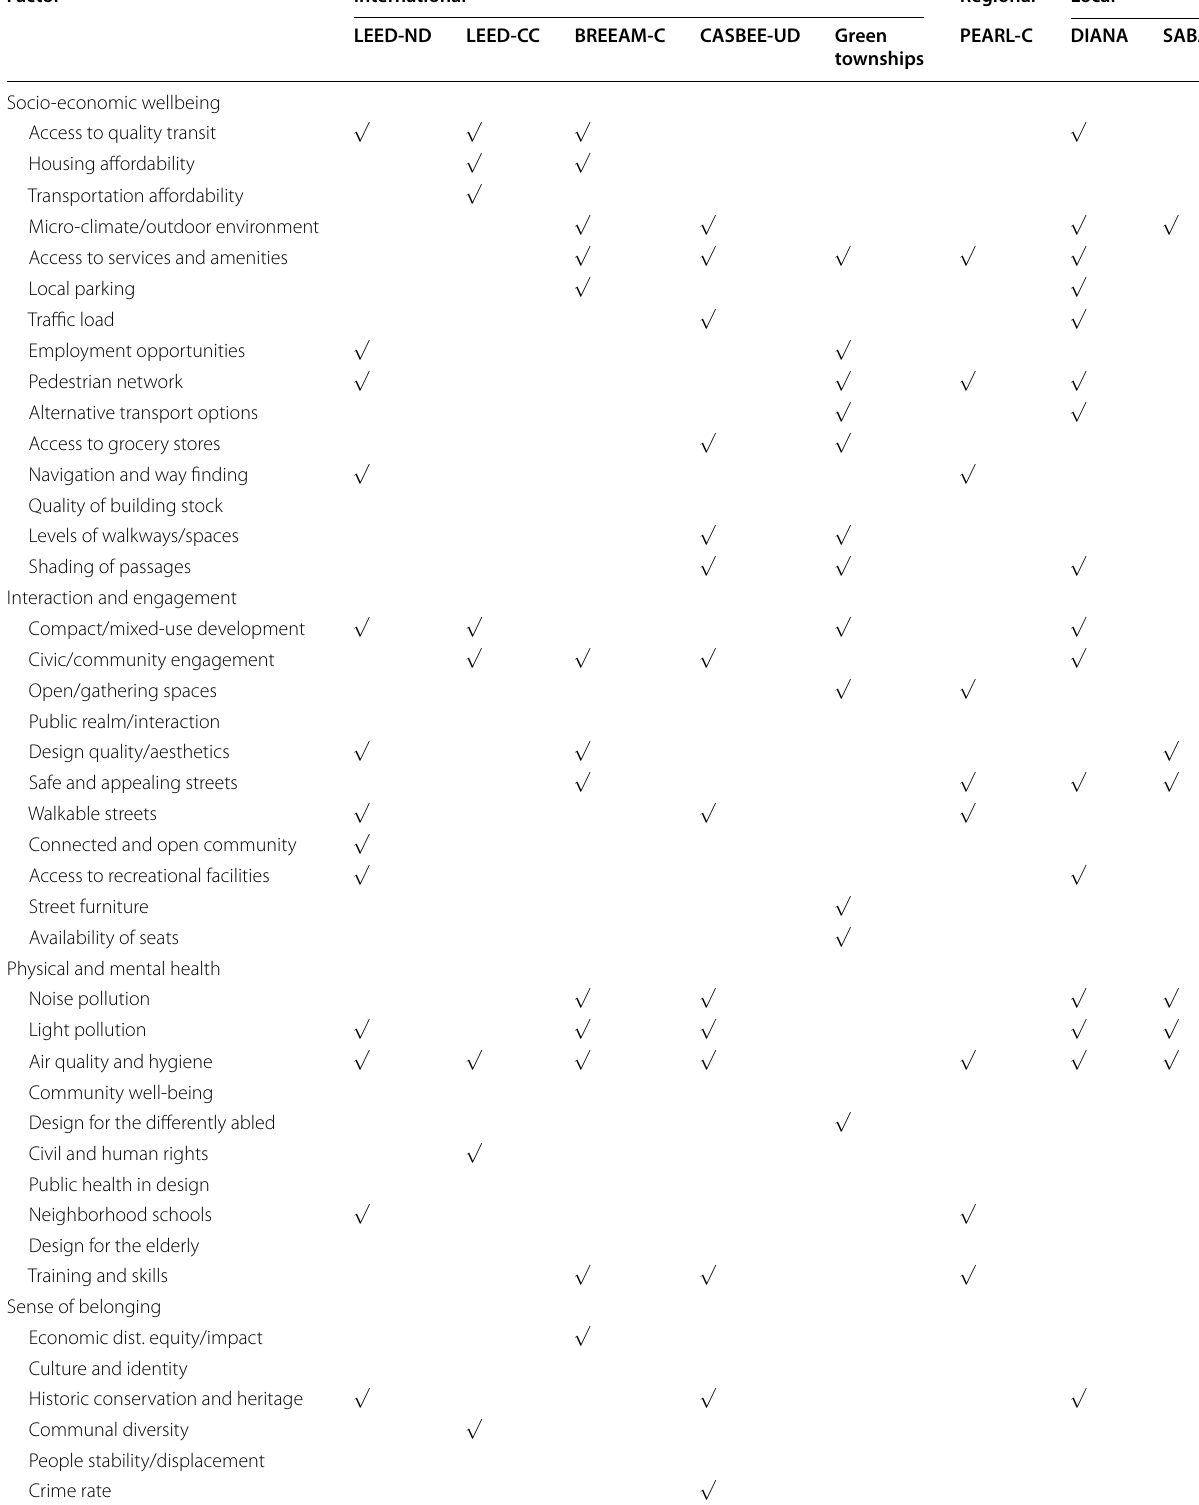
Table 8 Framework comparison with other global, regional, and local tools